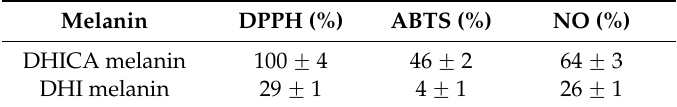
Table 1. Free radical scavenging properties of DHICA and DHI melanins [36].